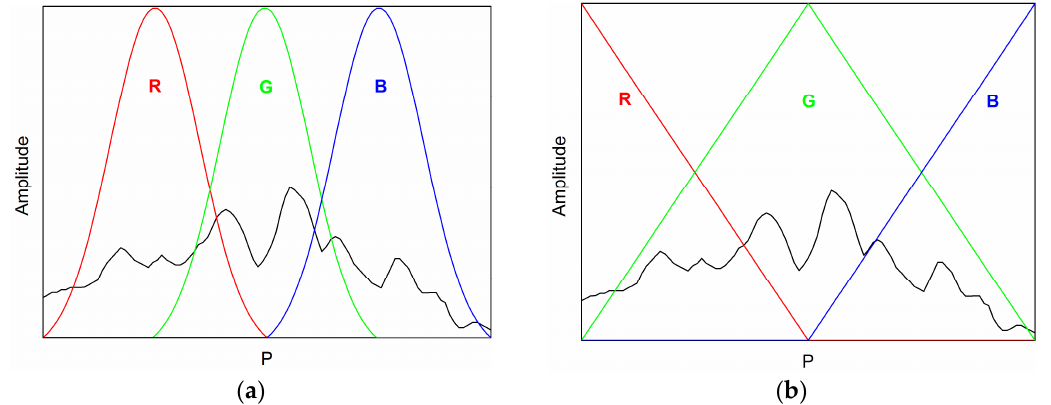
Figure 3. Two kinds of chromatic processor profiles: ( a ) Gaussian functions; and ( b ) triangular functions. R: red, G: green, B: blue.